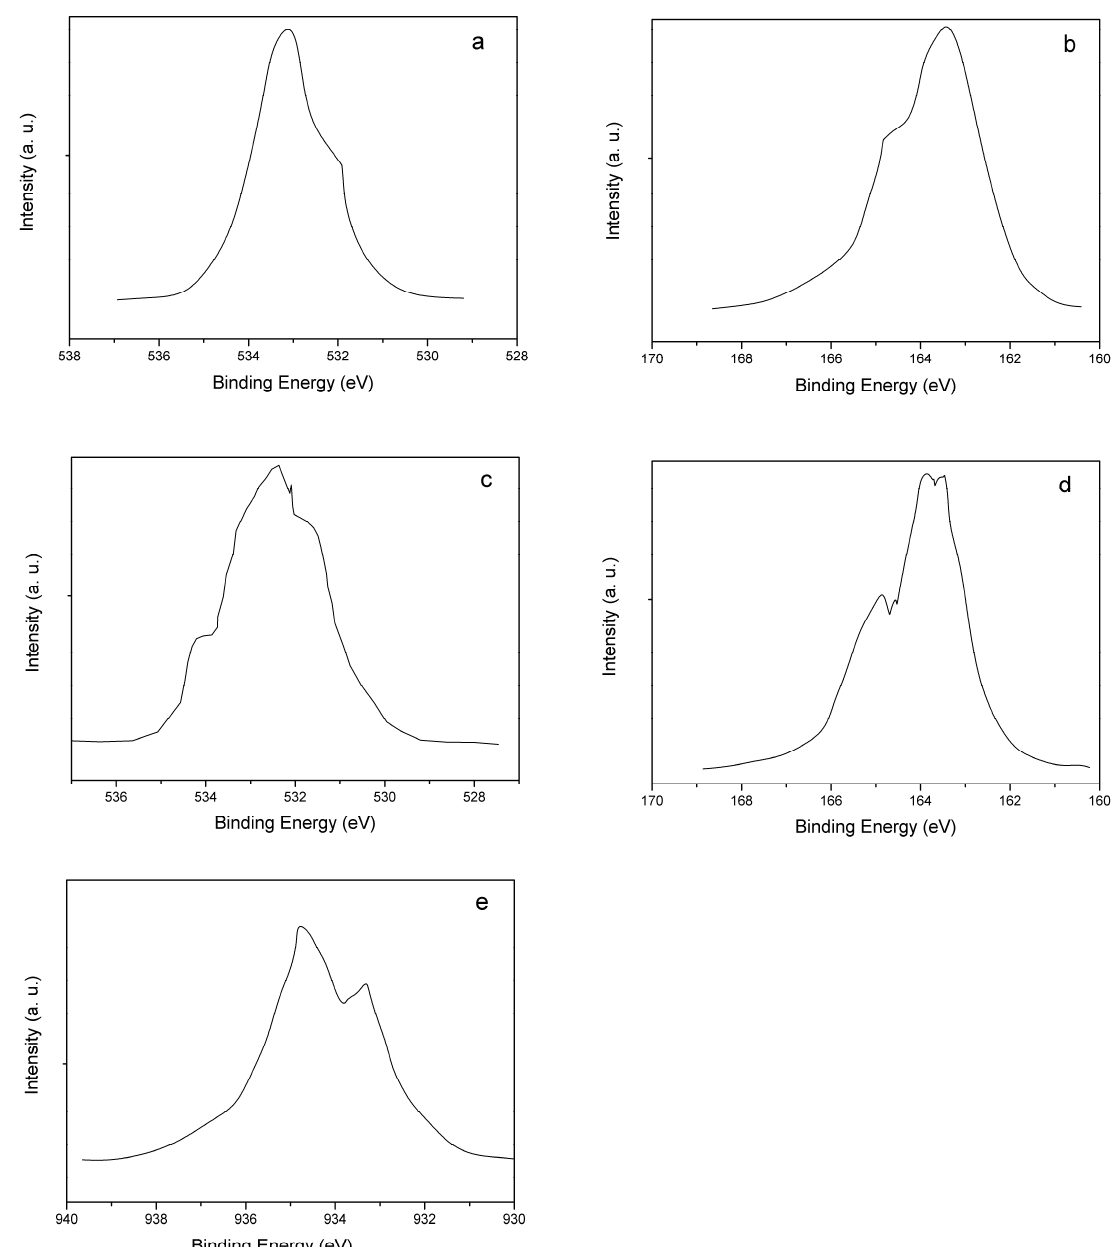
Fig. 2 X-ray photoelectron spectra: (a) O 1s spectrum of free III ligand; (b) S 2p spec- trum of free III ligand; (c) O 1s spectrum of Cu(L III ) 2 ; (d) S 2p spectrum of Cu(L III ) 2 ; (e) Cu 2p spectrum of Cu(L III ) 2